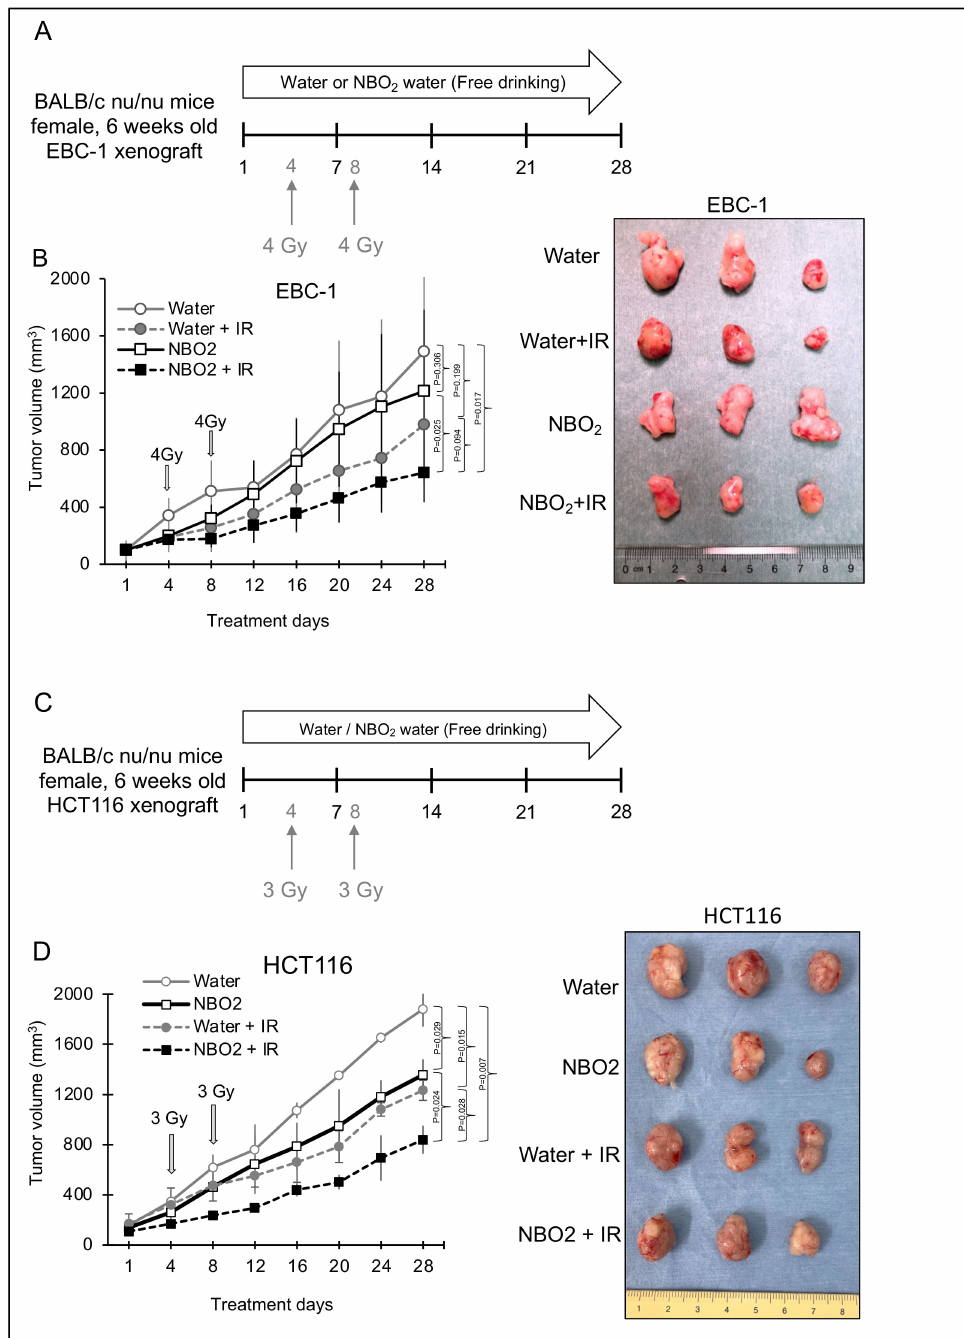
Figure 4. Therapeutic effect of drinking NBO 2 water and radiation in a tumor-bearing mouse model using EBC-1 and HCT116 cells. ( A , C ) Schedule of these studies. Oral intake of water and NBO 2 water was carried out from day 1 to day 28. Radiation (EBC-1, 4 Gy/fraction: HCT116, 3 Gy/fraction) against xenografted EBC-1 tumors on days 4 and 8. The xenograft tumors were harvested on day 28. ( B ) Left panel: tumor volume in an EBC-1 xenograft model in water, water + radiation (IR), NBO 2 , and NBO 2 + IR groups. Right panel: representative images of harvested tumors in each group taken on day 28. ( D ) Left panel: tumor volume in an HCT116 xenograft model in water, water + radiation (IR), NBO 2 , and NBO 2 + IR groups. Right panel: representative images of harvested tumors in each group taken on day